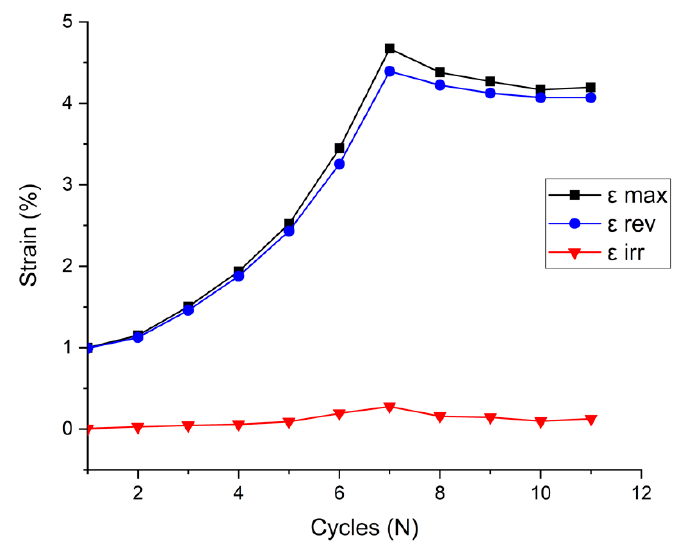
Figure 13. Maximum, reversible, and irreversible strain as a function of cycle.